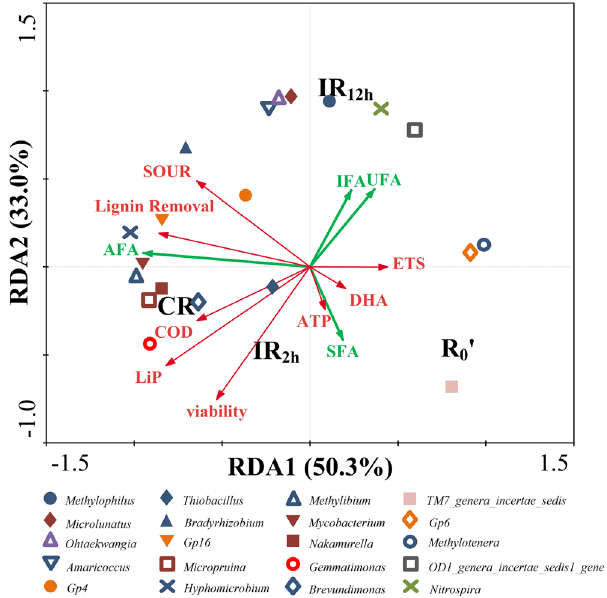
Figure 6. RDA analysis of microbial community in relation to phospholipid, effluent quality and physiological characteristics of activated sludge